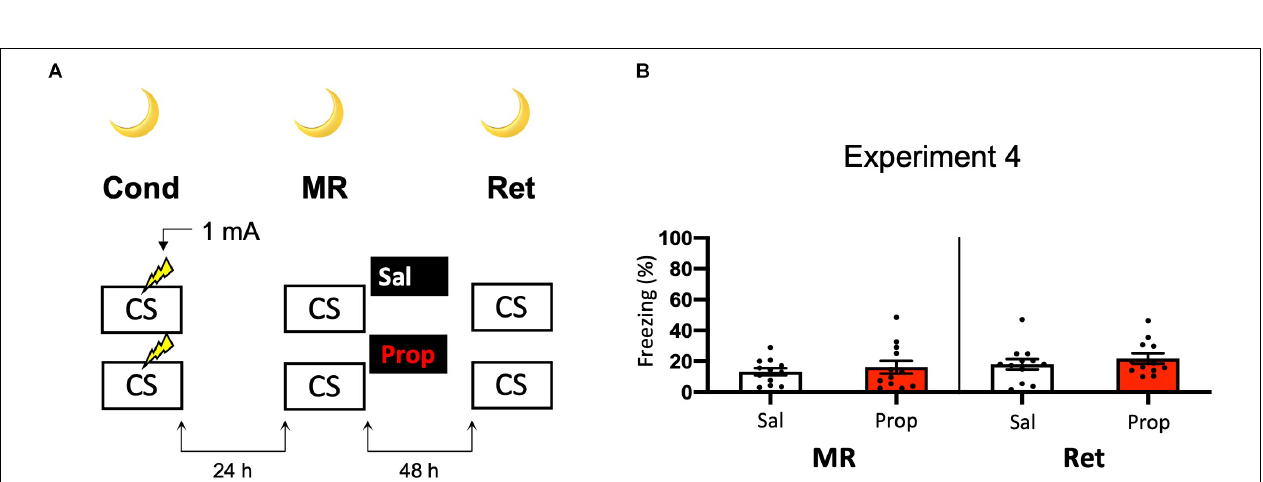
FIGURE 4 | No effect of propranolol on reactivated memories that were acquired with a single 1 mA shock during contextual fear conditioning in the animals’ dark phase. (A) Design of Experiment 4. Mice received one 1 mA shock during fear conditioning. One day later, mice received saline ( n = 12) or propranolol ( n = 12) after memory reactivation. Forty-eight hours afterward, retention of contextual fear was assessed. All procedures took place in the animals’ dark phase. Cond, conditioning; MR, memory reactivation; Ret, retention; CS, conditioned stimulus (context); Sal, saline; Prop, propranolol. (B) Results of Experiment 4. Average percentage of freezing during memory reactivation is displayed on the left, and freezing during the retention test on the right panel of the column chart (saline in white bars, propranolol in red bars). Error bars represent SEM. Filled circles indicate individual